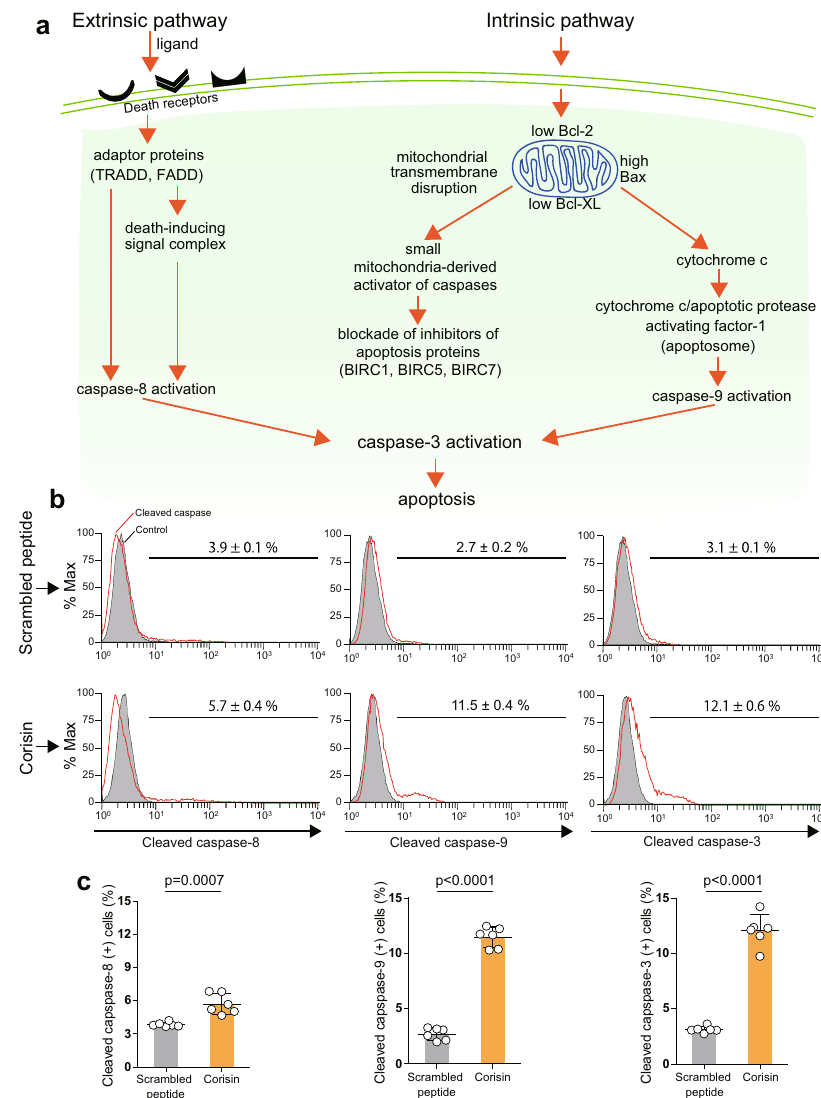
Fig. 2 Activation of cleaved caspases by corisin. a Apoptosis occurs by the extrinsic and intrinsic pathways. The extrinsic pathway is initiated by binding of ligands to membrane-bound death receptors that results in activation of intracellular signaling and cleavage of procaspase-8 to caspase-8. The intrinsic pathway is regulated by the mitochondrion. In the presence of the stimulus, perturbation of the mitochondrial membrane increases its permeability and causes the release of suppressors of baculoviral inhibitors of apoptosis repeat-containing (BIRC) proteins and proapoptotic factors, which contribute to apoptosome formation to cleave procaspase-9 to caspase-9. Both caspase-8 and caspase-9 can activate caspase-3, the effector of apoptosis. b , c A549 alveolar epithelial cells were cultured in the presence of 5 µ M corisin or scrambled peptide for 48 h. The percentage of cells positive for cleaved caspase-8, cleaved caspase-9 and cleaved caspase-3 was determined by fl ow cytometry and quanti fi ed. N = 6 in each group. Data are expressed as the mean ± S.D. Statistical analysis was performed using two-sided unpaired t test. The source data underlying ( c ) are provided in the Source Data fi of alveolar epithelial cells with activated caspase-9 and activated caspase-3 compared to control stimulation, as shown by cyto-